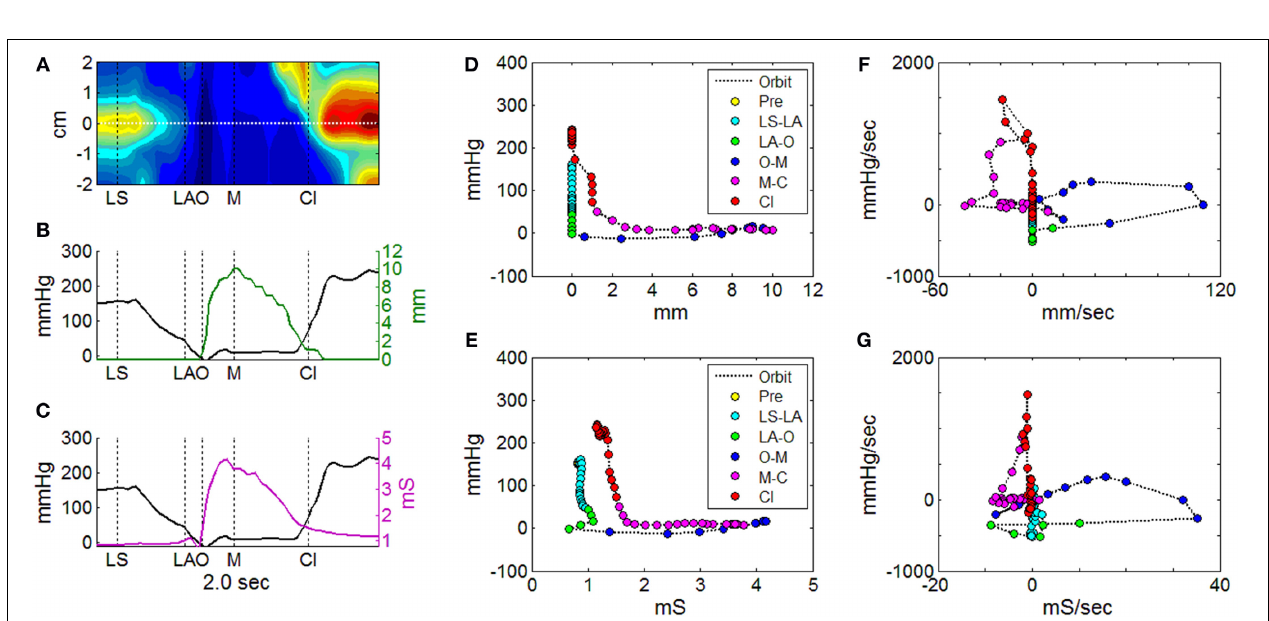
FIGURE 7 | Orbit plots to describe UES pressure and UES opening over the time of a single swallow. (A) Spatio-temporal plot of pressures recorded during UES relaxation and opening. Horizontal white line indicates the midpoint position of the reference impedance segment over which average diameter was calculated. Vertical black lines indicate timings of important radiological features; onset of laryngeal superior movement (LS), onset of laryngeal anterior movement (LA), onset of UES opening (O), maximum UES diameter (M), and UES closure (Cl). (B) Plot of pressure (at position 0cm in A ) and mean